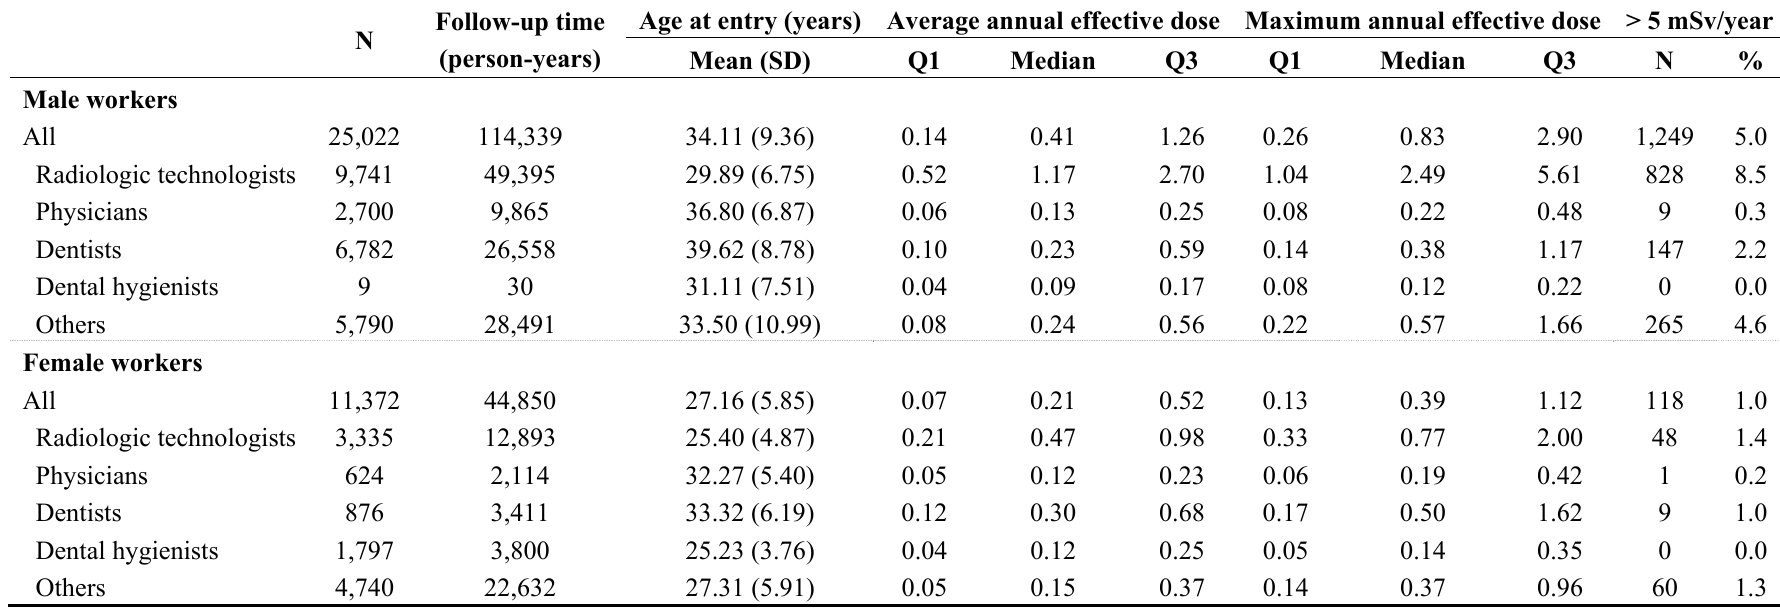
Table 1. Occupational radiation exposure doses in diagnostic radiation workers by profession, Korea,